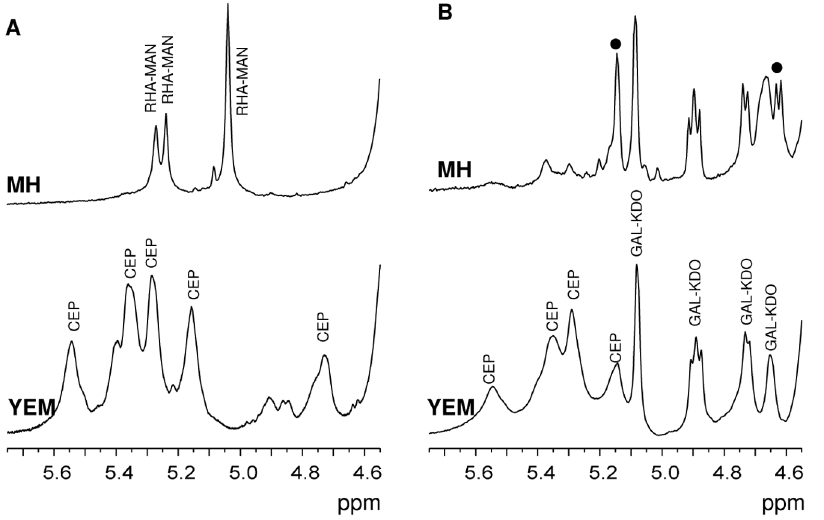
Figure 5. 1 H-NMR spectra of exopolysaccharides from biofilms. A) anomeric region of the 1 H-NMR spectra of the EPOLs obtained from biofilms of B. multivorans C1576 produced on cellulose membranes deposited on MH (top) and YEM (bottom) agar plates; B) anomeric region of the 1 H NMR spectra of EPOLs produced by B. cenocepacia BTS2 in biofilm conditions in MH (top) and YEM (bottom) media. CEP , GAL-KDO and RHA- MAN indicate signals belonging to the respective polysaccharides. Circles indicate new resonances of unknown identity.